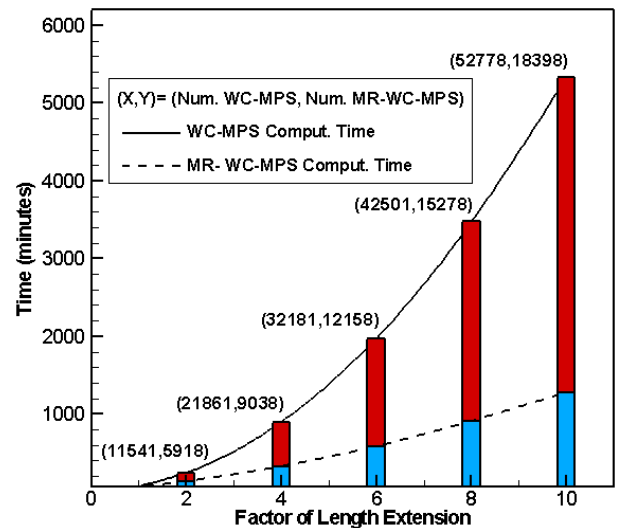
Figure 14. A Comparison between the WC-MPS and MR-WC-MPS computational time for simulation of landslide-induced water waves over extended